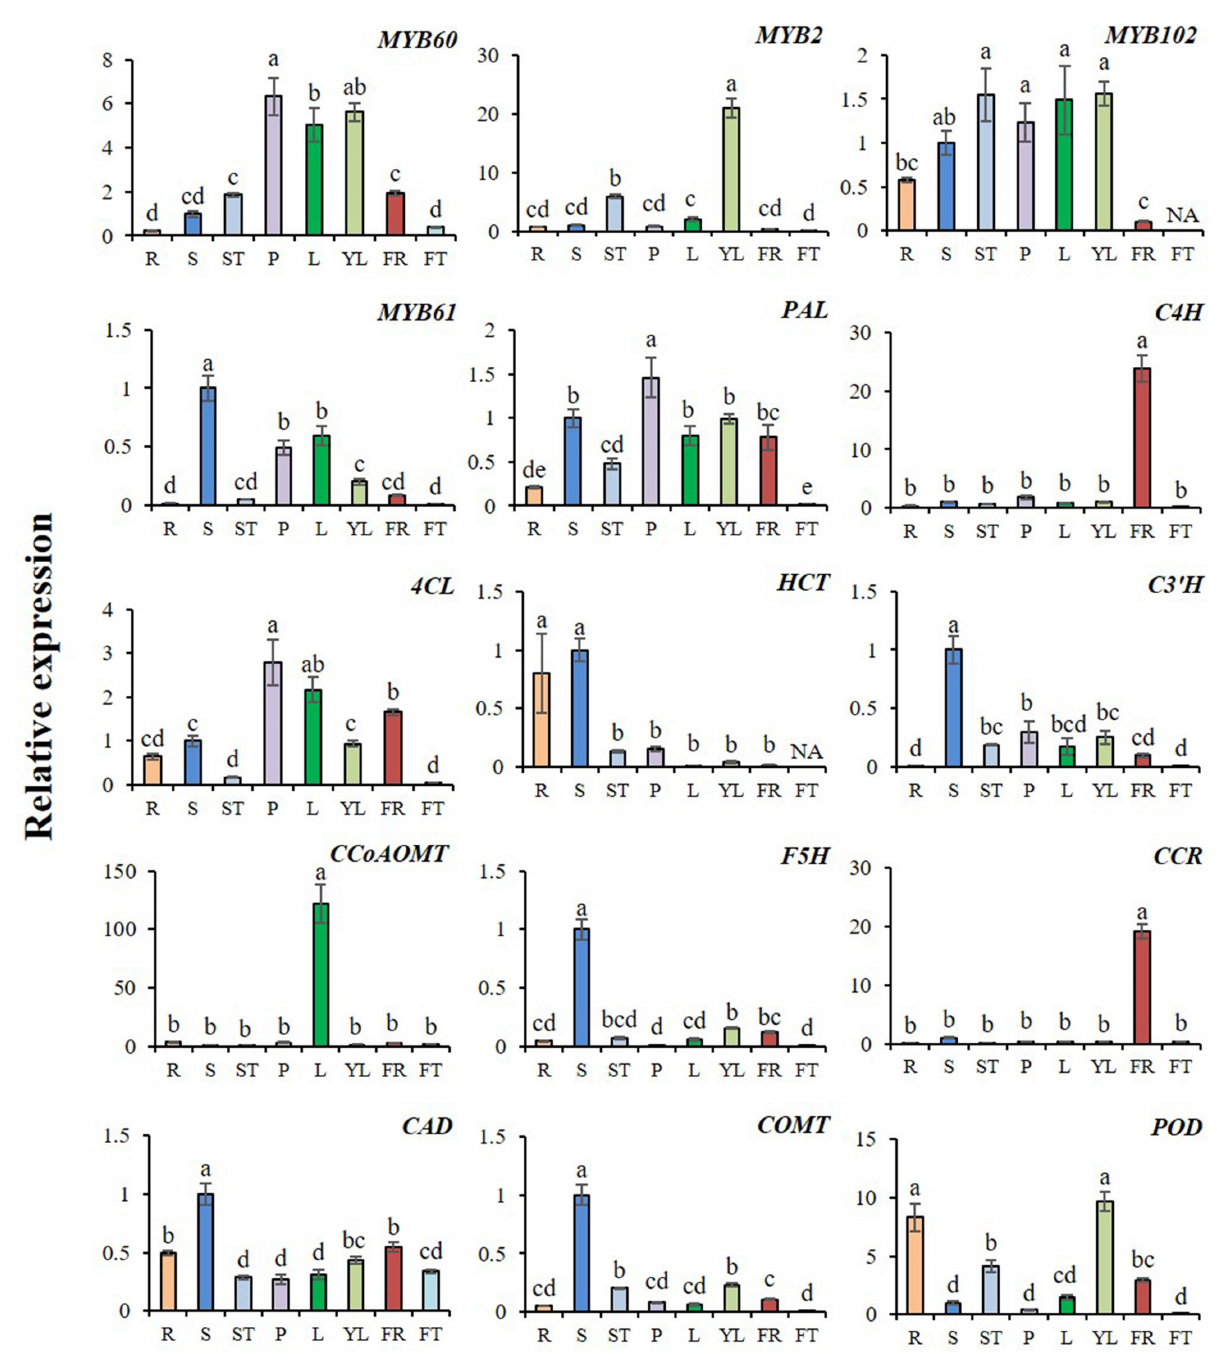
Figure 8. Relative expression levels of AcMYBs and lignin-biosynthesis-related genes in different tissues of kiwifruit. The expression level of this gene in the stem was taken as 1. The relative expression level of genes was calculated by normalization method. R. Root, S. stem, ST. stem tip, P. petiole, L. leaf, YL. young leaf, FR. flower, FT. fruit. Different superscript letters indicate significant differences between different treatments at p < 0.05 level. NA indicates that the expression level is lower than the minimum value detectable by the instrument.